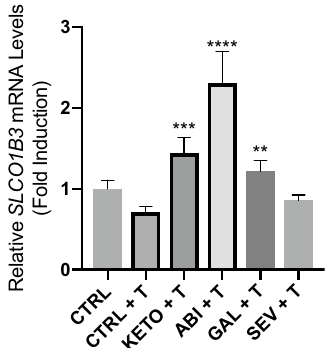
Figure 2. The effect of CYP inhibitors on SLCO1B3 expression. 22Rv1 cells were treated with four CYP17 inhibitors, ketoconazole (Keto), abiraterone (ABI), galeterone (GAL), or seviteronel (SEV), in media supplemented with 1 nM testosterone for 24 h. Cells were treated with ketoconazole and abiraterone at a concentration of 20 µM and galeterone and seviteronel at a dose of 10 µM based on precedents set for in vitro experiments in previous publications. RNA was extracted and assessed for changes in SLCO1B3 expression using qPCR. Gene expression was normalized to expression of β-actin. All CYP17 inhibitors but seviteronel produced statistically significant induction of SLCO1B3 in 22Rv1 cells. Statistical tests were performed against CRTL + T. Data represent three independent experiments with triplicate measurements. **P < 0.001, ***P < 0.0001, ****P < 0.00001.